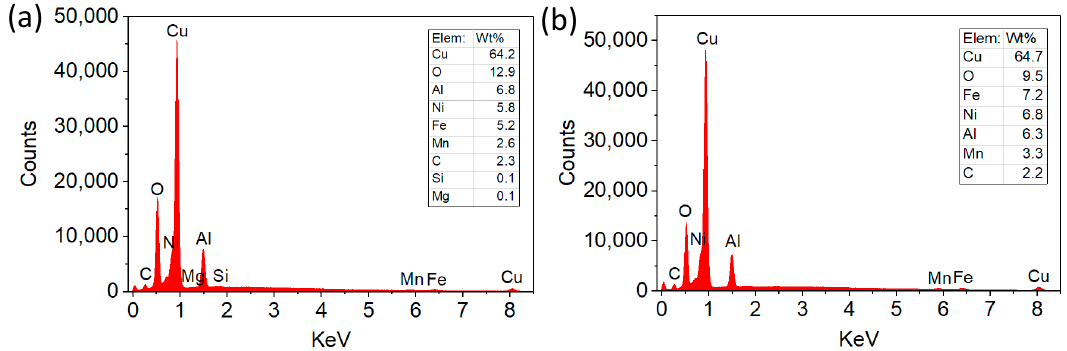
Figure 9. EDS patterns of the wear debris: ( a ) fretting; ( b ) sliding.